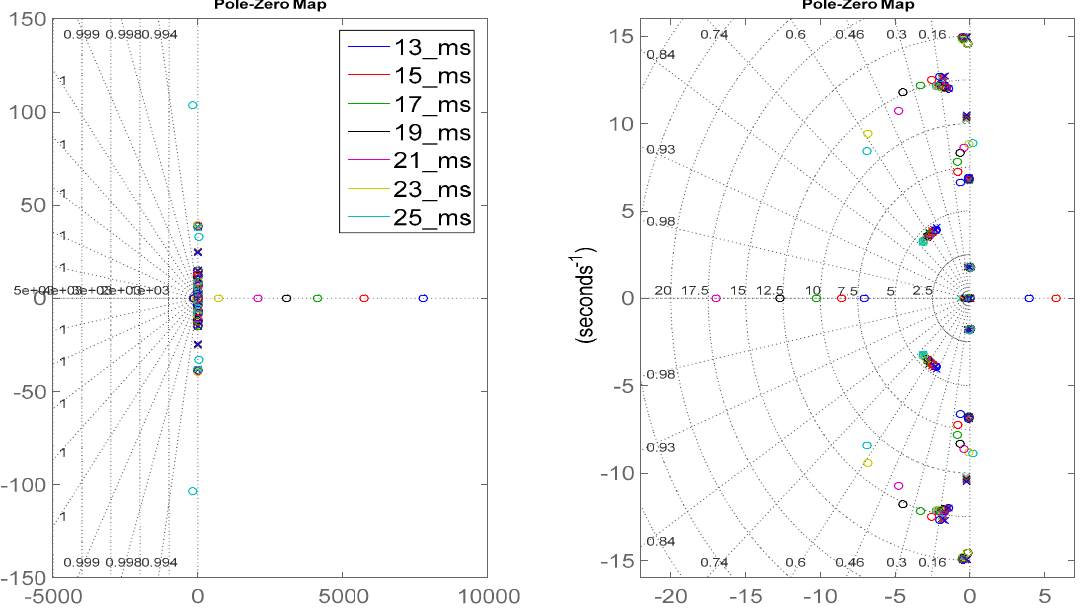
Figure 2. Pole and zero map of the LTI models of the pitch system at various operating conditions.